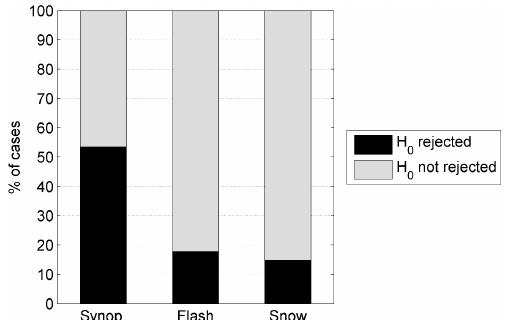
Figure 3. Results of the comparison of the empirical copulas re- gionally: per cent ratio of the cases where the equivalence of the empirical copulas was rejected or could not be rejected at the given level of significance (here α = 10%). Within the set of 72 sites, and for each flood process separately, altogether 2556 (72 × 71 / 2) pair- wise comparisons were carried out. The black color indicates the percent ratio of the cases where the null hypothesis about the equal- ity of the empirical copulas for the given flood process was rejected.